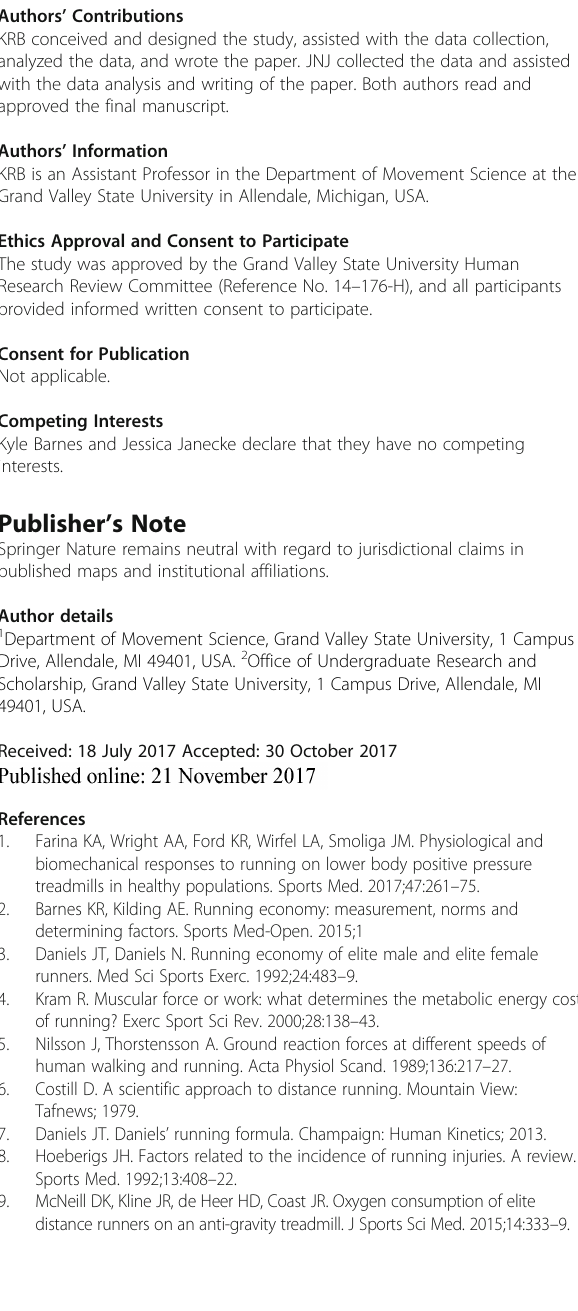
table for running on lower body positive pressure treadmills. J Strength Cond Res. 2015;29:854 –